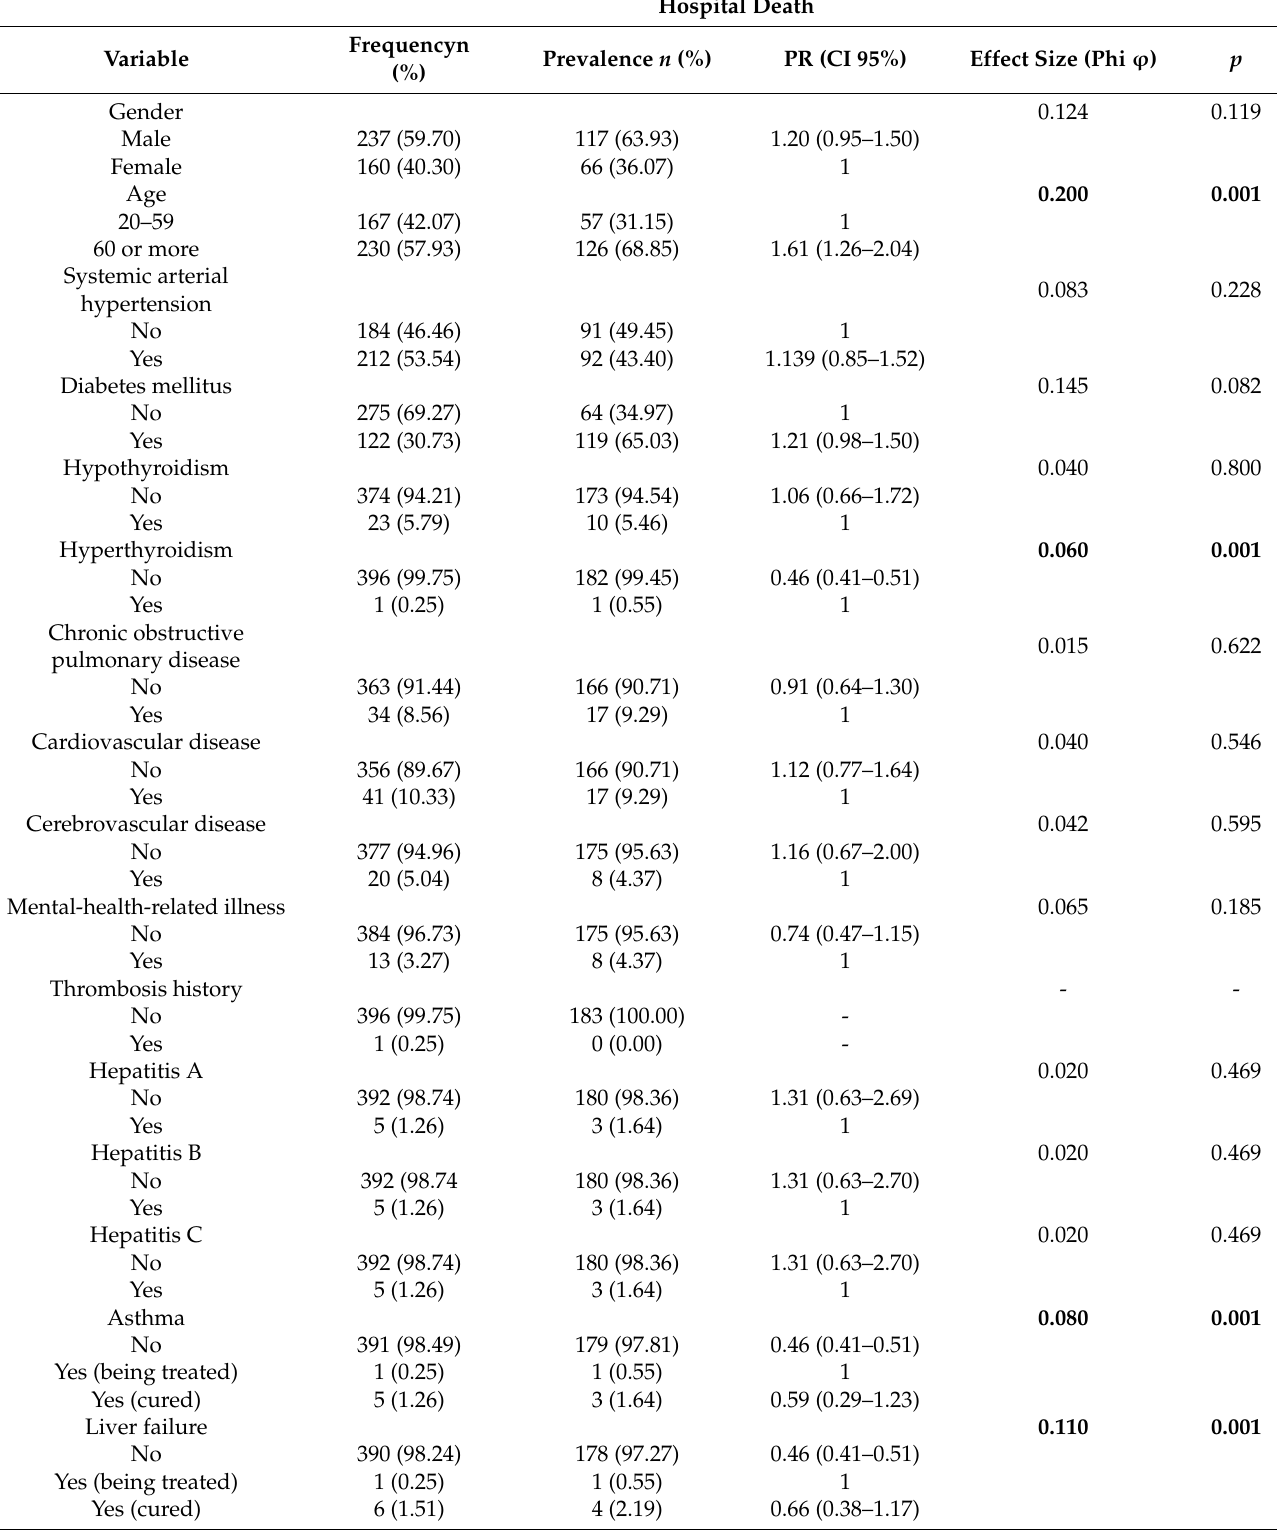
Table 1. Association between hospital death in patients with severe acute respiratory syndrome owing to COVID-19 and sociodemographic data, chronic diseases, lifestyle, and treatment ( n = 397). Hospital